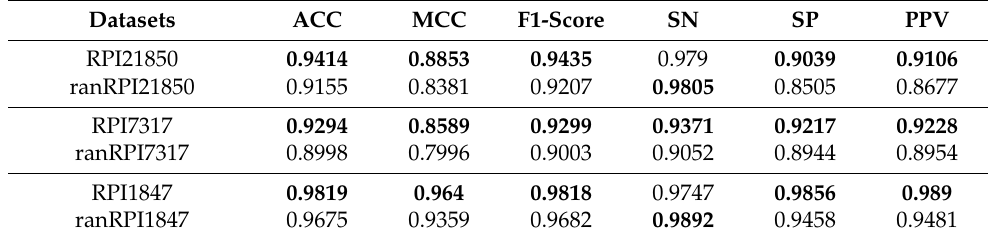
Table 4. Results of LGFC-CNN on six datasets generated by different negative sample generation